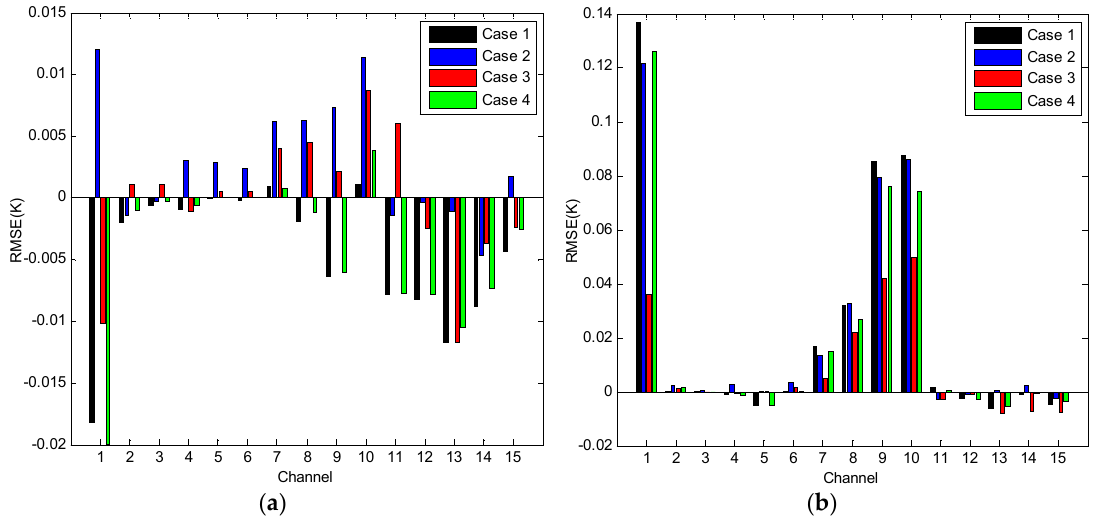
Figure 12. The differences of the RMSE of the bias correction between four bias corrections and the NNC bias correction in Section 5.1. ( a ) Over ocean; ( b ) over land.